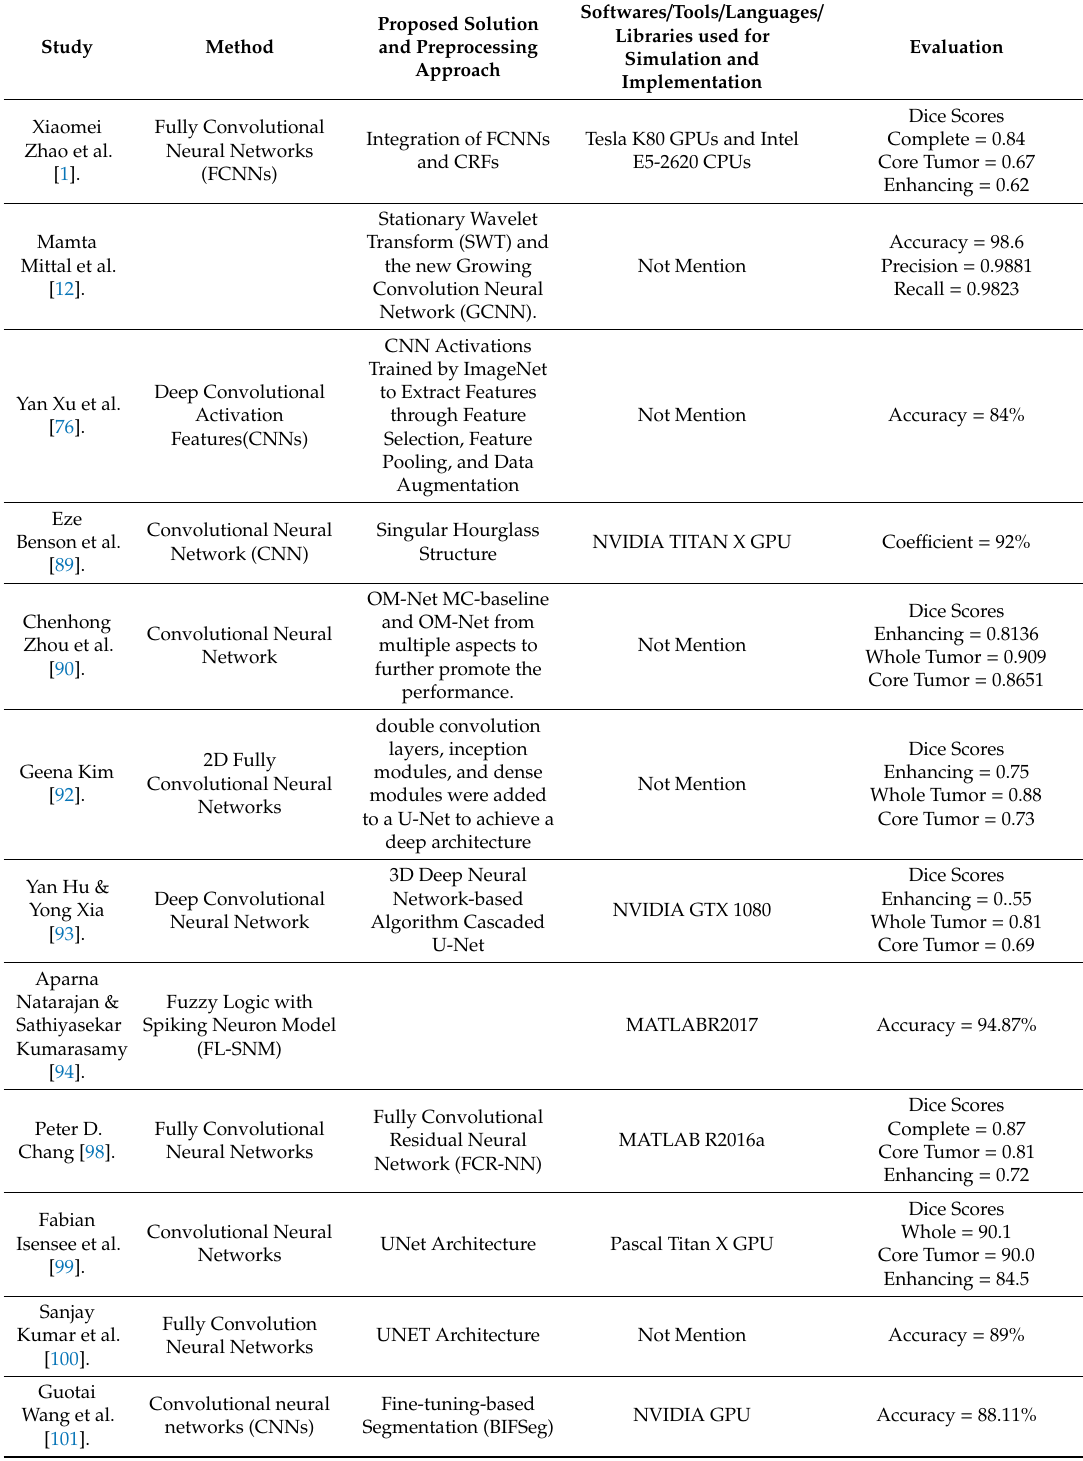
Table 5. Overview of papers using deep learning for brain tumor